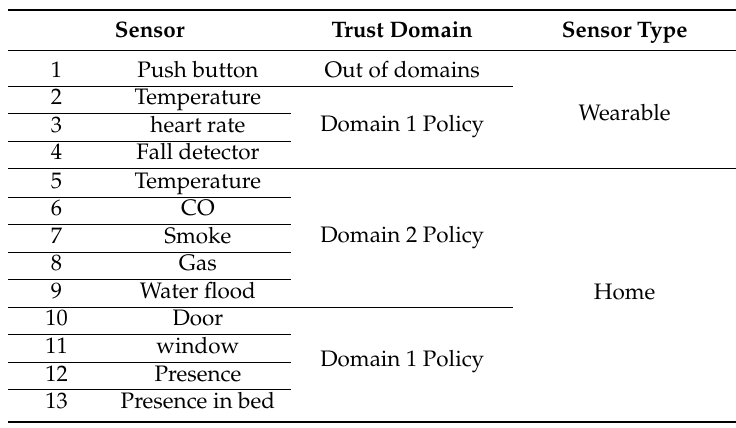
Table 7. Trust domains